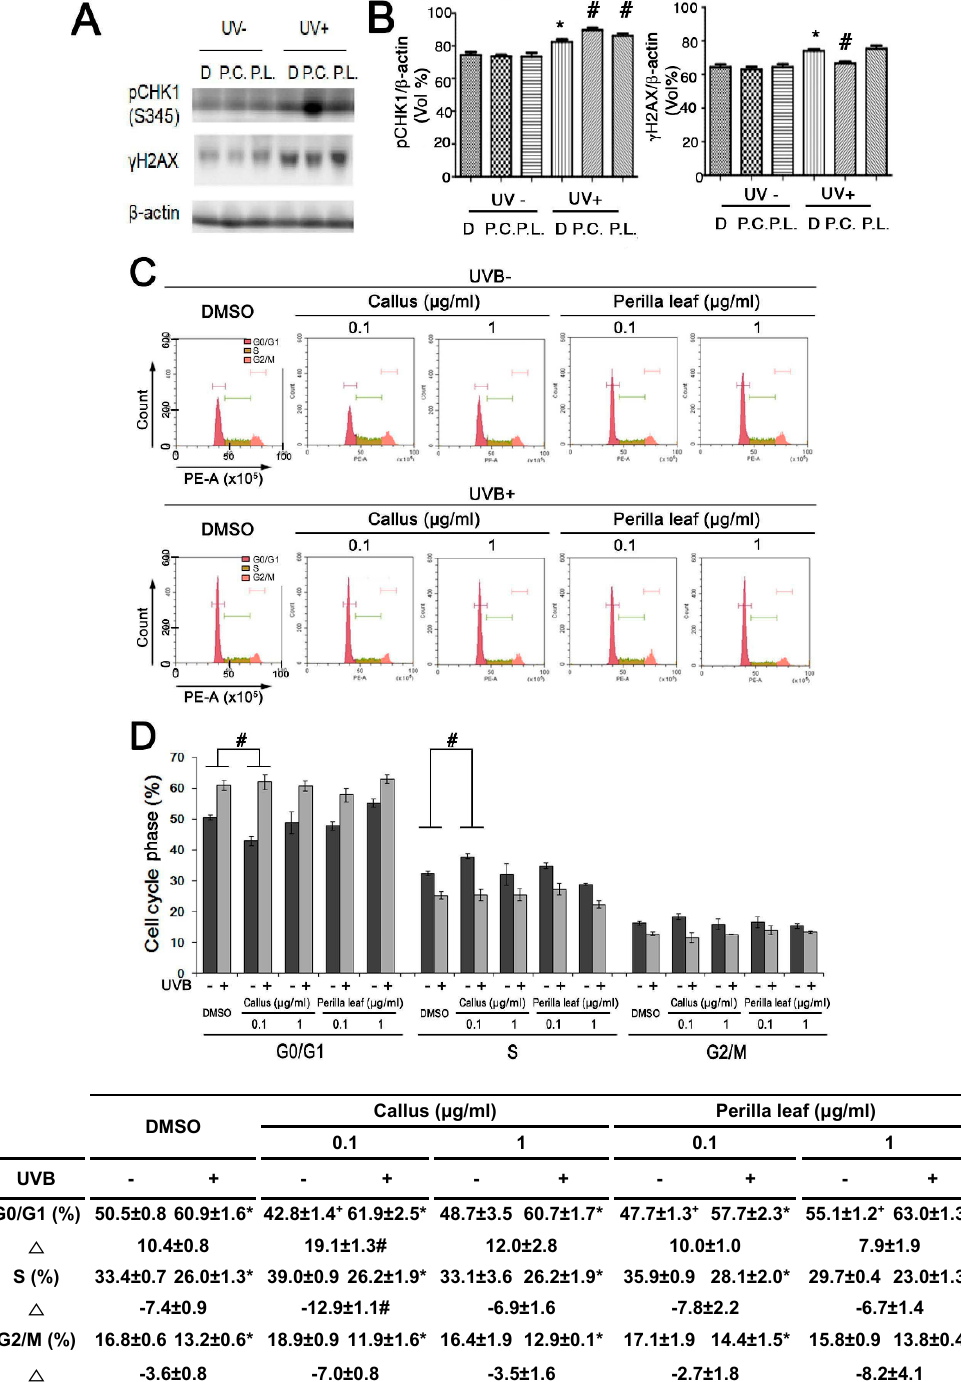
Figure 5. Effect of Perilla leaf and callus extracts on the cell cycle distribution of UVB exposed HaCaT cells. ( A ) Representative Western blot for phosphorylated checkpoint kinase 1 (pCHK1) (S345) and γ H2AX proteins in HaCaT cells treated with Perilla leaf or callus extracts at 0.1 µ g/mL (D: DMSO treatment; P.C; Perilla callus; P.L: Perilla leaf). β -Actin was used as the loading control. Proteins were analyzed using the Fusion image system (Fuji, Japan). Cells were treated with Perilla extracts overnight, washed with Phosphate-buffered saline (PBS), and irradiated with UVB (30 mJ/cm 2 ), and 3 h later, pellets were harvested for Western blotting. ( B ) Results are presented as the means ± SDs of three biological replicates in two independent measurements (please see all images in supplementary Figure S2). * p < 0.05 versus UVB non-treated controls. # p < 0.05; versus UVB treated comparisons. ( C , D ) Cell cycle analysis was performed by propidium iodide stain- ing in asynchronized HaCaT cells. The proportions of cells in different phases of the cell cycle were determined by flow cytometry. ( C ) Representative histograms show cell cycle distributions. HaCaT cells were subjected to fluorescence-acti- vated cell sorting (FACS) analysis. Histograms show side scatter (SS) and forward scatter (FS) for all events. The parame- ters of FACS analysis are referred to as FSC-A: Forward Scatter-Area; FSC-H: Forward Scatter-Height and SSC-A: Side Scatter-A. (D) Bar chart presentations of cell cycle distributions after treatment with Perilla leaf or callus extract and UVB (30 mJ/cm 2 ). The cell cycle distribution table shows percentages of cells in the three phases (G0/G1, S, and G2/M). Results are presented as the means ± SDs of triplicate plates per sample. * p < 0.05; significant versus UVB non-treated controls. + p < 0.05; significant versus UVB non-treated controls on G0/G1 phase. Δ ; change of UVB treated from UVB untreated in each cell cycle phase. # p < 0.05; significant versus change ( Δ ) of DMSO treatment.